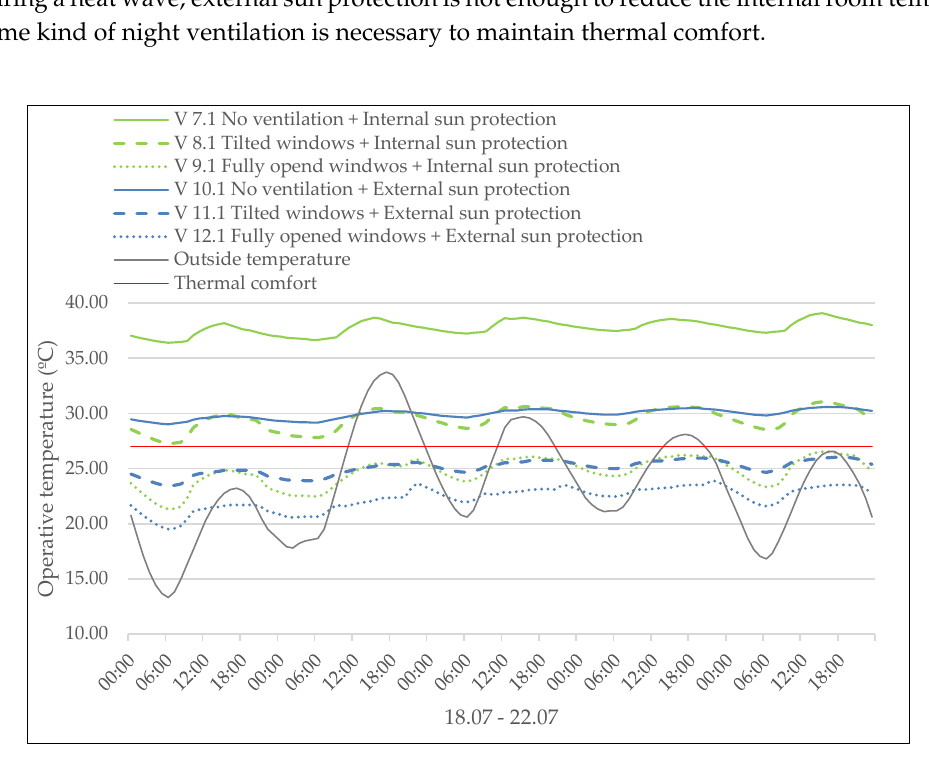
Figure 5. Current climate scenario — Variants of sun protection and night ventilation, based on [33].